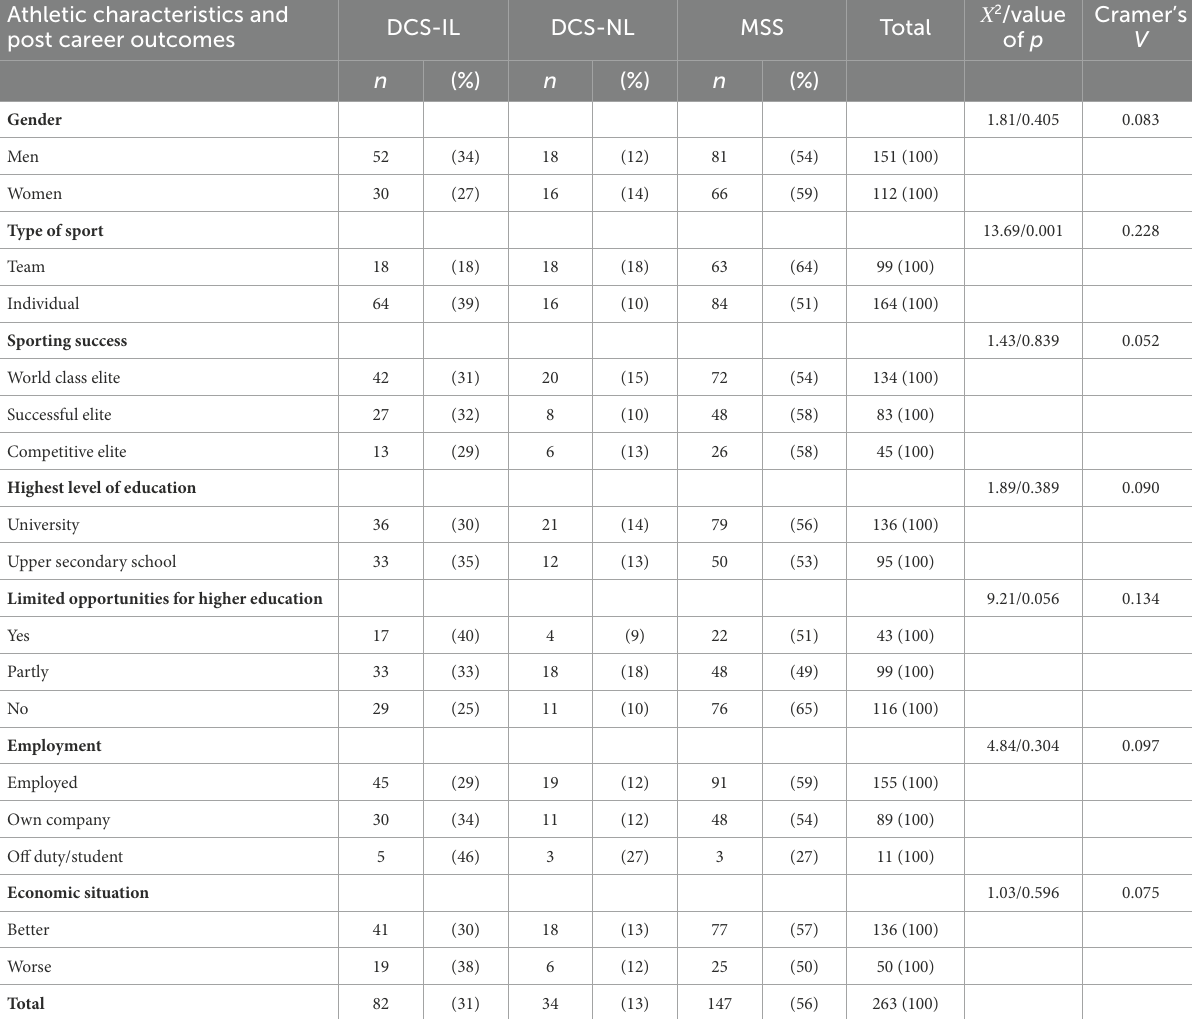
TABLE 2 The relationship between attending a dual career sport program/school and athletic characteristics as well as post career educational and employment outcomes. Athletic characteristics and post career